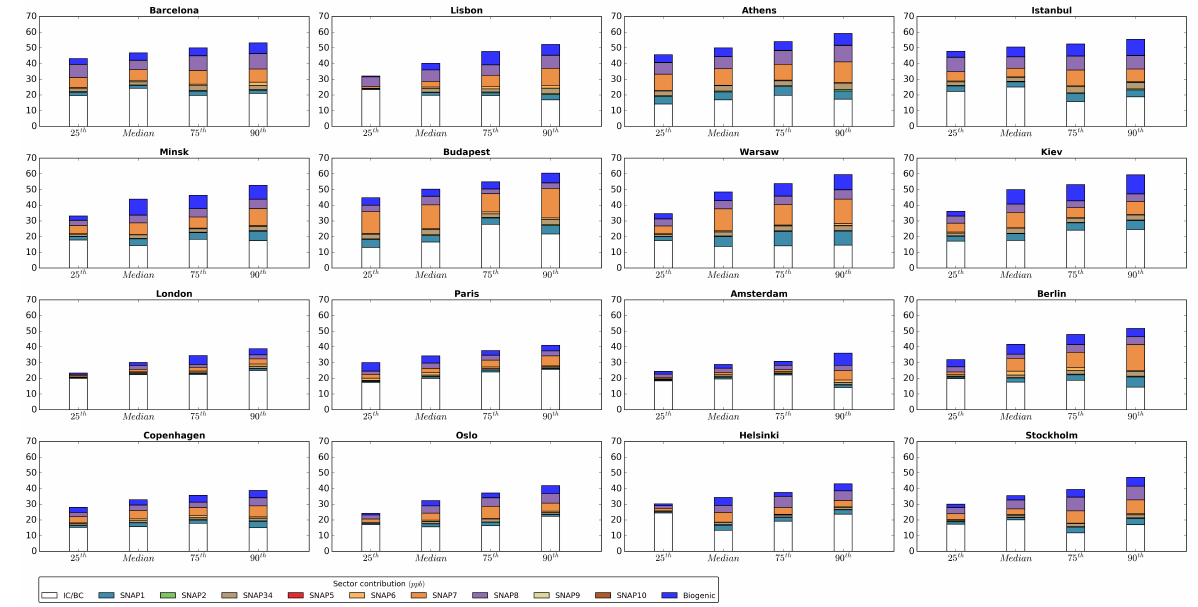
Figure 8. Source attribution results for the distribution of summertime MDA8 ozone concentrations for the 16 cities.